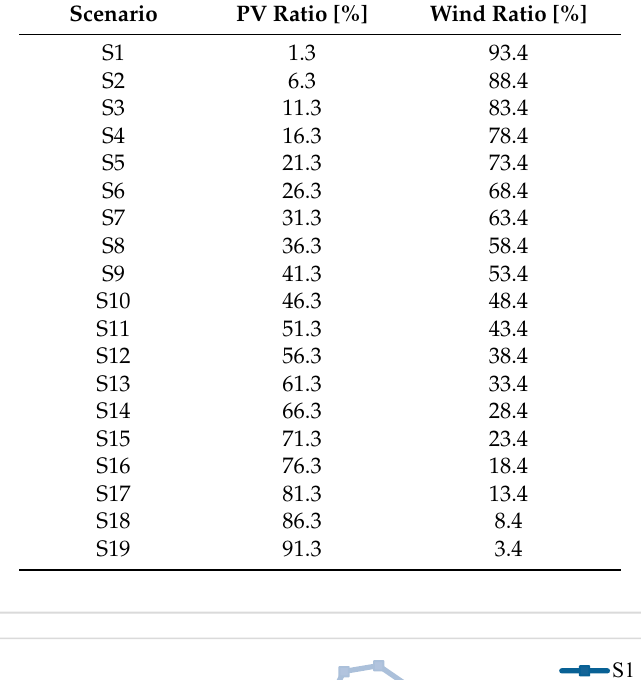
Table 1. VGR mix scenarios for the peak-load day.